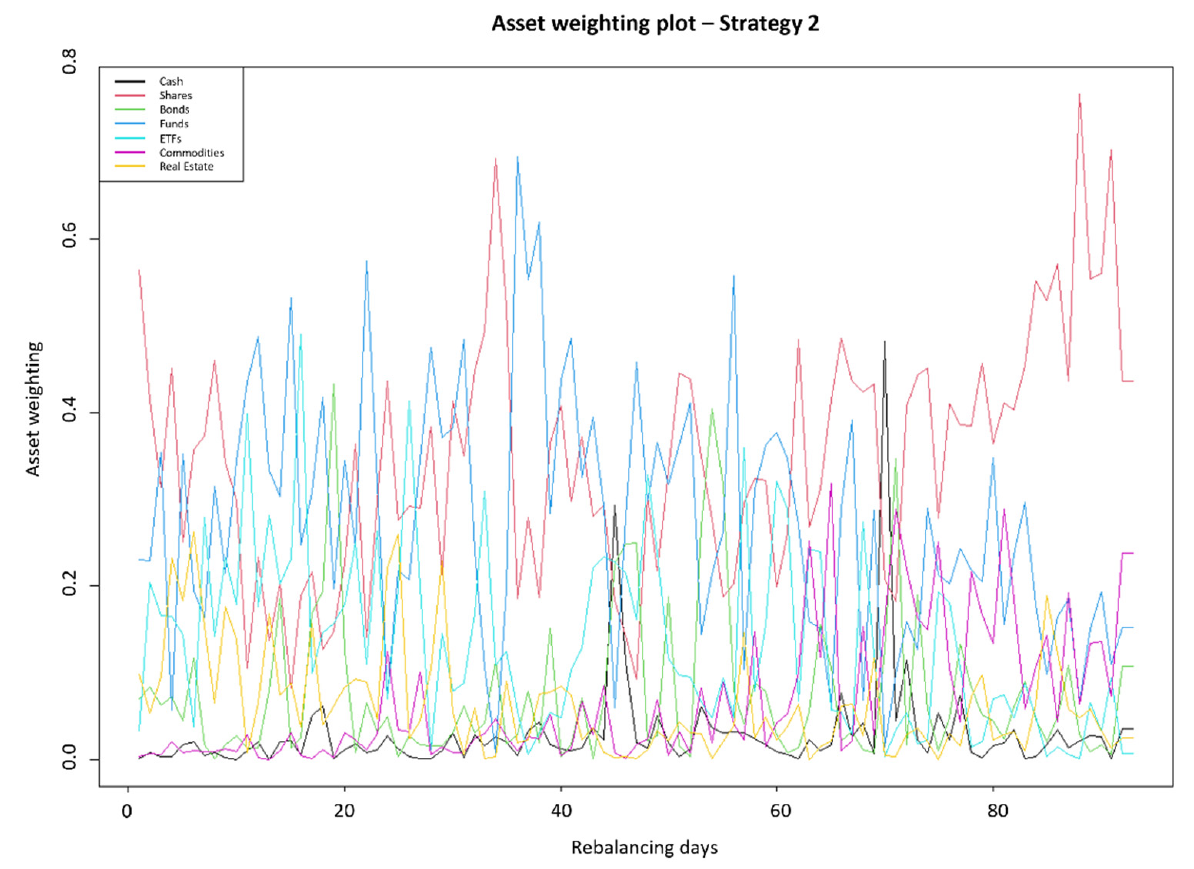
Figure 6 . The asset weights plot of Strategy 2 . Figure 6. The asset weights plot of Strategy 2.